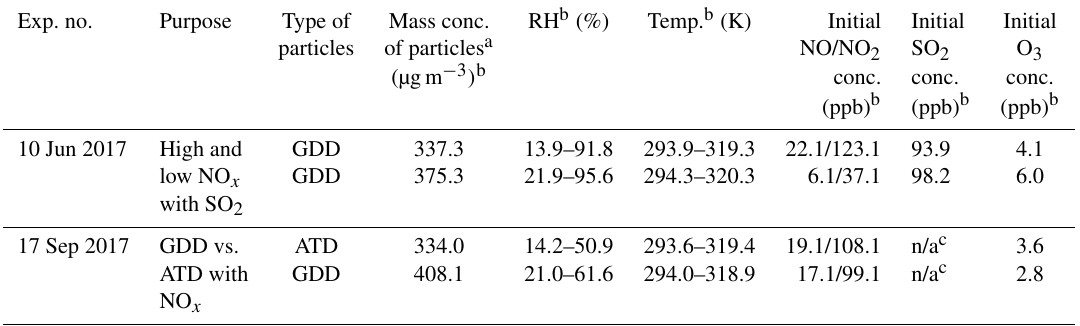
Table 1. Outdoor chamber experimental conditions for NO x and SO 2 oxidation in the presence of Gobi Desert dust (GDD) particles and Arizona test dust (ATD) particles. Exp. no. Purpose Type of Mass conc. RH b (%) Temp. b (K) Initial Initial Initial particles of particles a NO/NO 2 SO 2 O 3 (µgm − 3 ) b conc. conc. conc. (ppb) b (ppb) b (ppb) b 10 Jun 2017 High and GDD low NO x GDD with SO 2 17 Sep 2017 GDD vs. ATD ATD with GDD NO